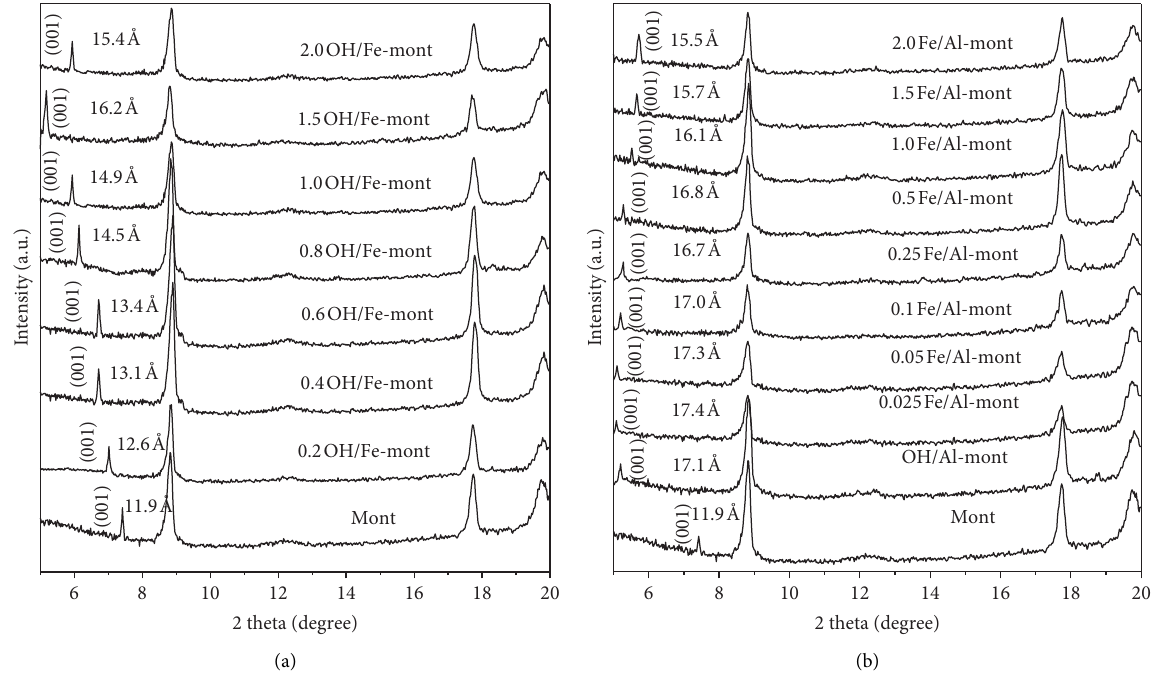
Figure 8: X-ray diffraction patterns of hydroxyl-Fe-Al-pillared Mont.